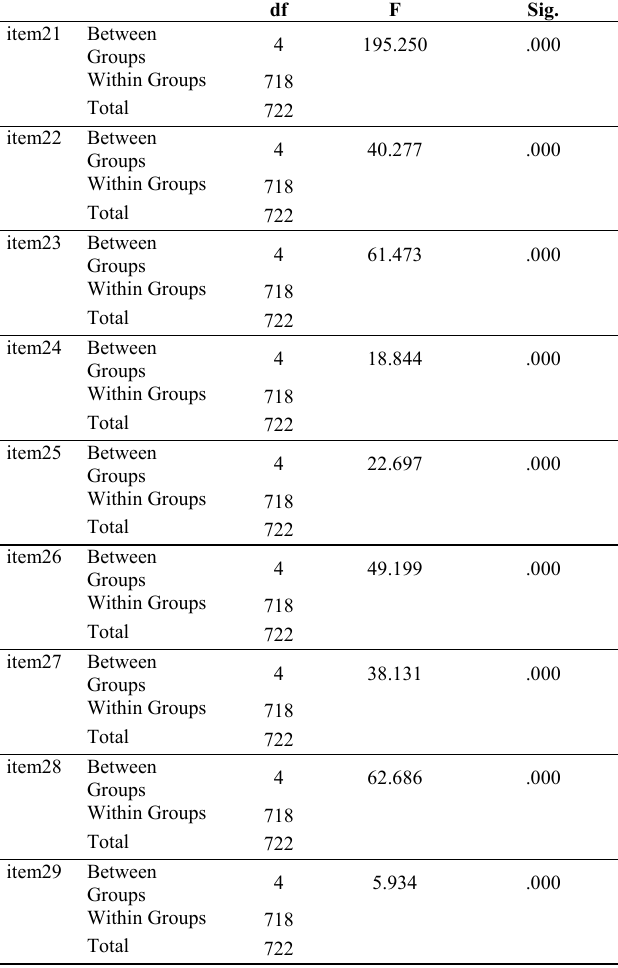
Table 17: The ANOVA for the influence of the features of furniture product design on the fuzzy semantics of the perceived values of consumers with different incomes